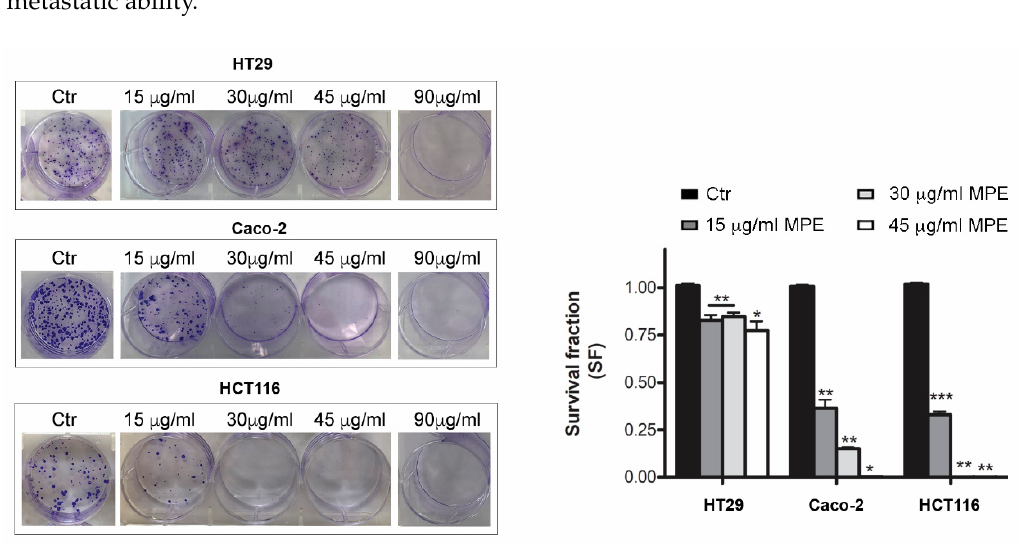
Figure 3. Cytotoxic effect of MPE evaluated using clonogenic assay in colon cancer cells. Culture dishes with crystal violet stained colonies treated with MPE. The ability of cells to produce colonies, as reported in Materials and Methods, was evaluated after 10 days. Pictures of a representative experiment are reported. In the right panel statistical results of colony-forming assays were reported as survival fraction (SF) of colonies number with respect to untreated condition used as control. Statistical significance was assessed by the Student’s t-test: (*) p < 0.05, (**) p < 0.01 and (***) p < 0.001 compared to the untreated sample. The data in the bar chart are expressed as mean number ± SD of three different experiments.